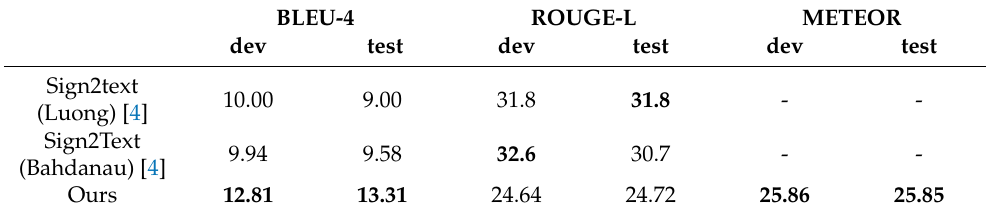
Table 9. Comparison with other models in PHOENIX